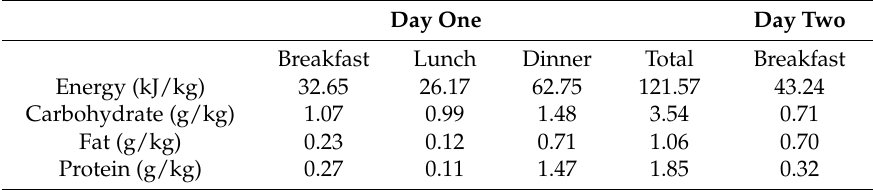
Table 1. Energy and macronutrient composition of test meals on Days 1 and 2 of each intervention. Day One Day Two Breakfast Lunch Dinner Total